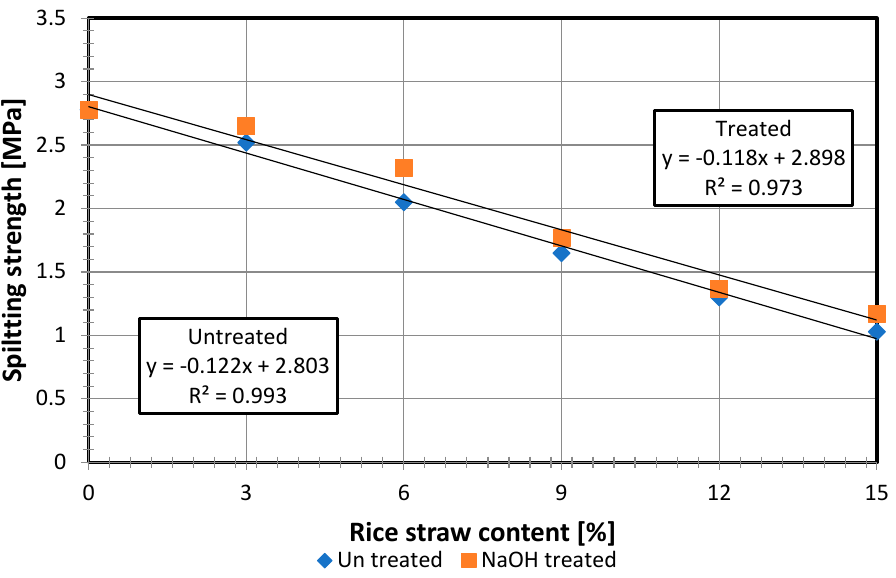
Figure 8. Splitting tensile strength of the treated and untreated rice straw concrete at different percentages of rice straw.